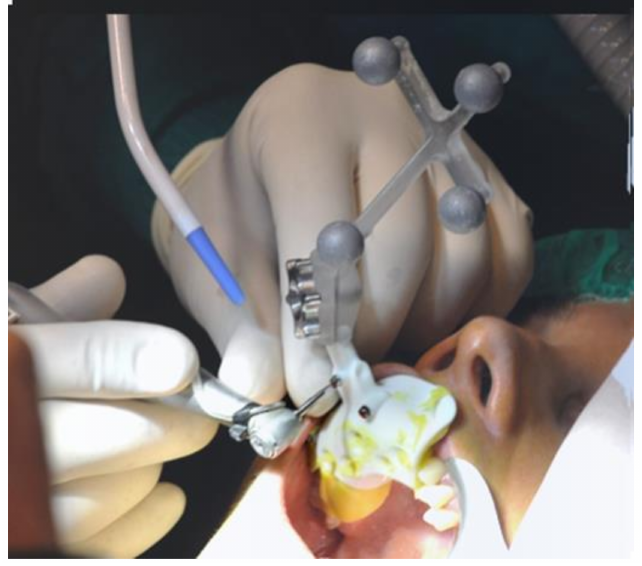
Figure 2. The registration/calibration just before the surgical procedure.